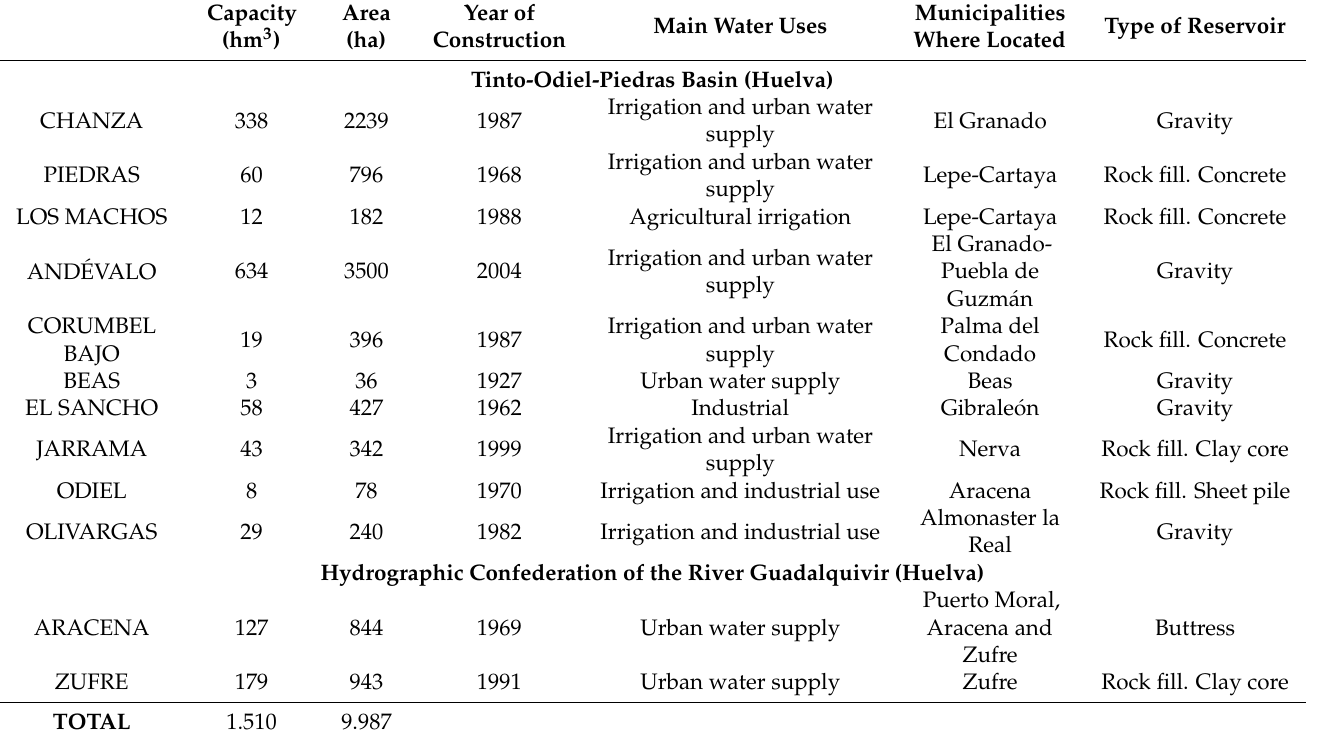
Table 5. Reservoir capacity of the Huelva